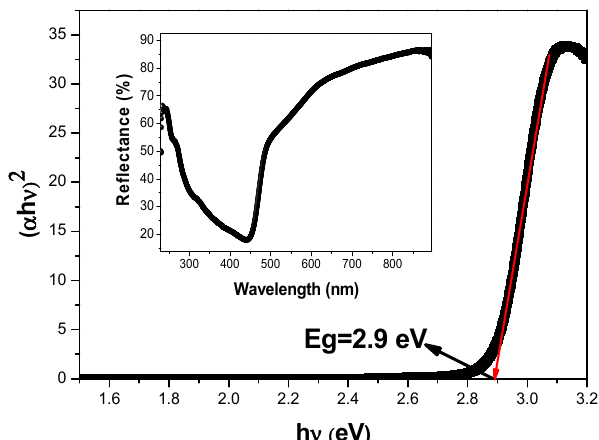
Figure 6. ( α h ν ) 2 versus photon energy. Inset: UV-vis spectrum of Bi 12 ZnO 20 .